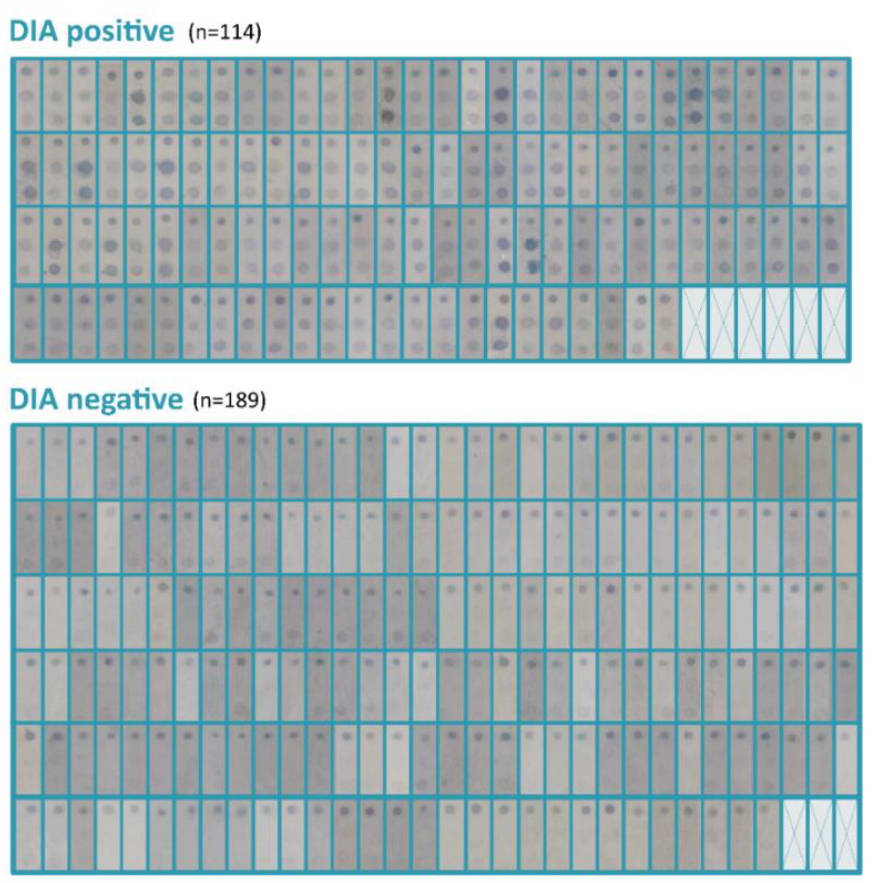
Figure 3. Imaging of DIA testing results. Graphical evidence of DIA tests carried out with 303 CF serum samples; 114 of them yielded a positive result for anti- Scedosporium / Lomentospora serum IgG, while 189 were negative for the rapid test.